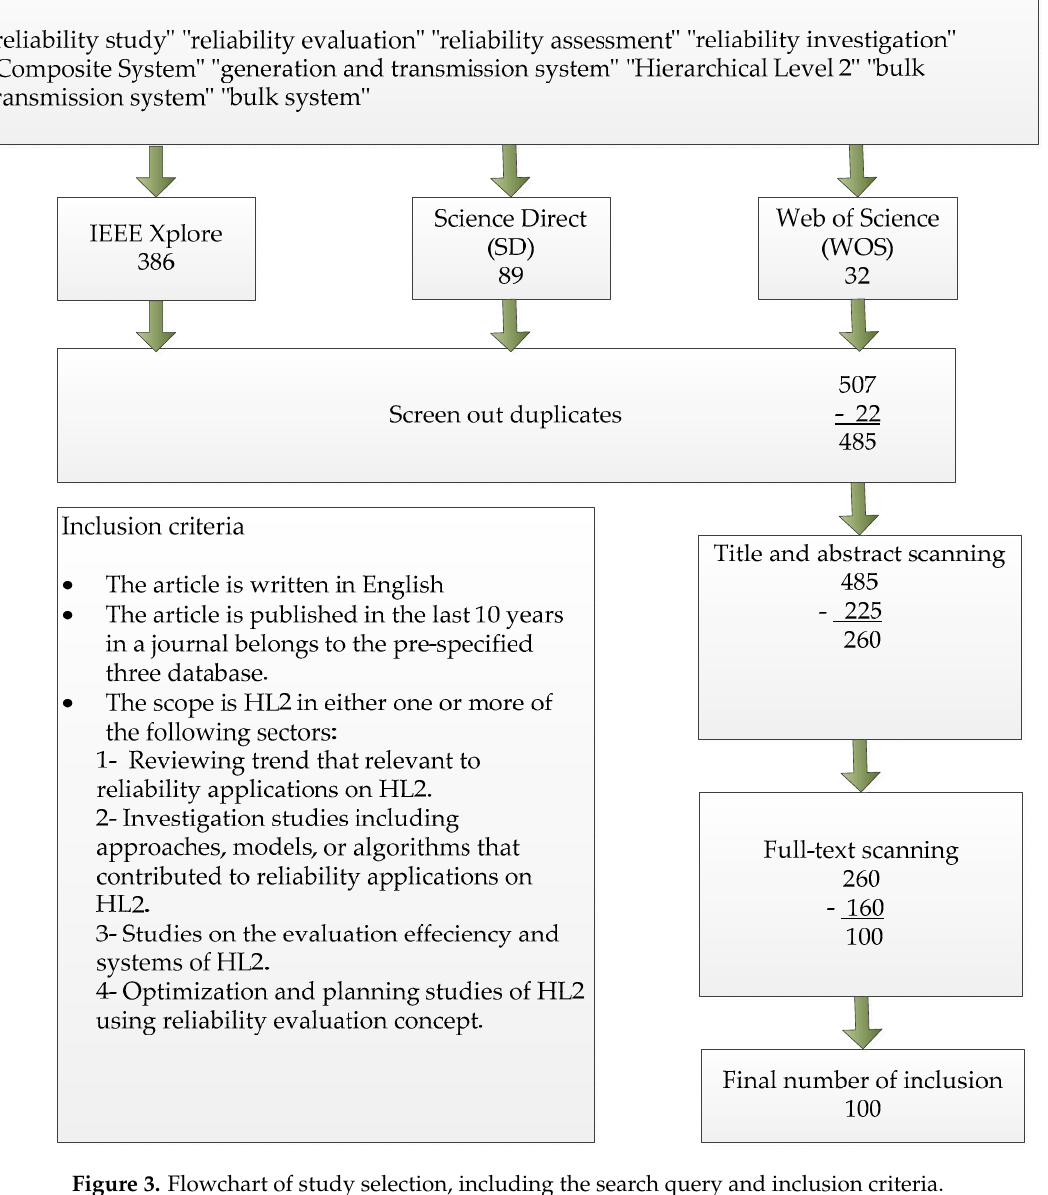
Figure 3. Flowchart of study selection, including the search query and inclusion criteria.